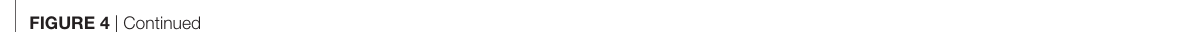
FiGURe 4 | Continued Physiological functions of ataxin-2. (A) Promotion of mRNA translation of specific genes via its interaction with the PABP and 3 ′ untranslated regions in the polyribosomes; (B) global suppression of translation under stress conditions via its interaction with the miRNA pathway proteins Ago1 and Me31b; (C) control of endocytosis through its binding to endophilins; (D) regulation of the calcium signaling pathway through the control of translation of some of their components; and (e) sensoring of nutritional and energetic state of the cells through the direct and/or indirect inhibition of the mTORC1 signaling pathway. Atxn2, Ataxin-2; PABP, polyA binding protein; eIF3, eukaryotic initiation factor 3; eIF4A, eukaryotic initiation factor4A; eIF4E, eukaryotic initiation factor 4E; IF4G1, eukaryotic initiation factor 4G1; Ago1, Argonuate 1; Me31b, Deadbox helicase me31B; SERCA2, smooth endoplasmic reticulum Ca-ATP-ase 2; INPP5A, inositol polyphosphate-5- phosphatase; Atp2a2, gene encoding the SERCA2 protein; RORA, retinoic acid-related orphan receptor alpha; PI3K, phosphoinositide 3-kinase; mTOR, mechanistic target of rapamycin; ITPR1, inositol triphosphate receptor 1; RPS6, ribosomal protein S6; 4E-BP, eIF4E-binding